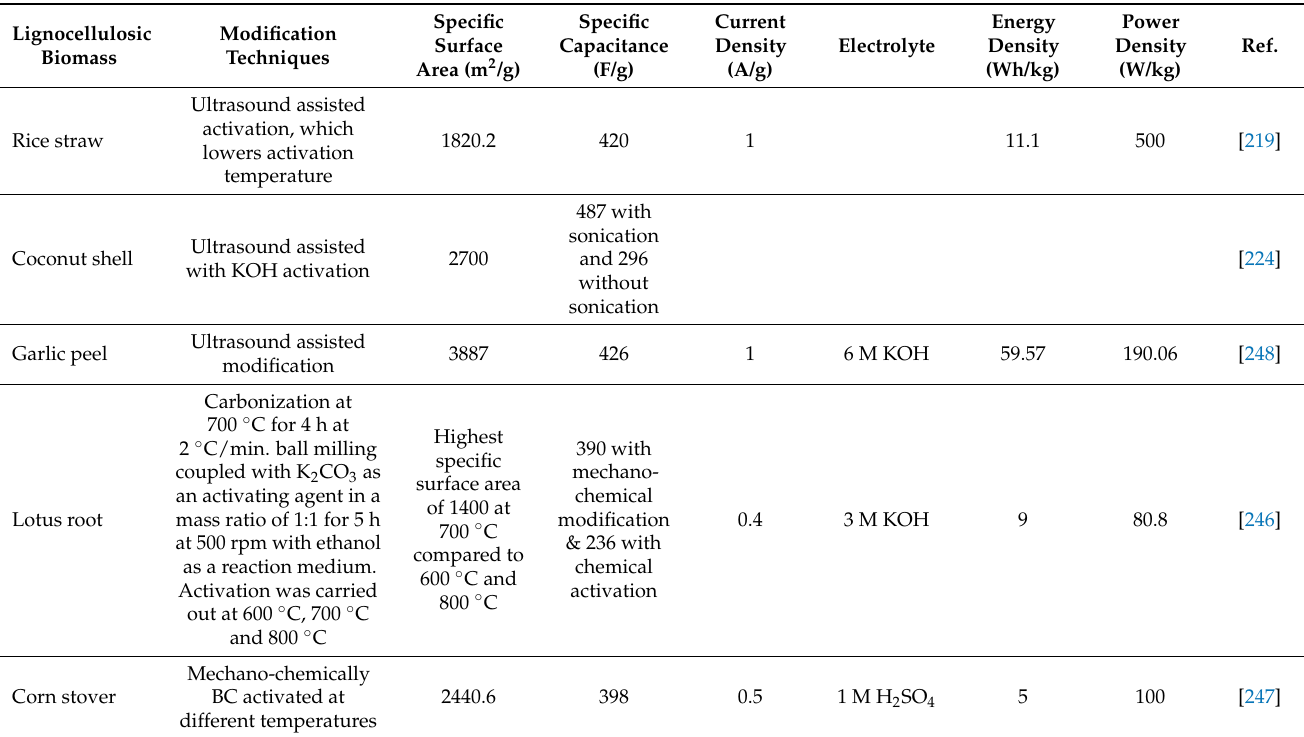
Table 5. Sonochemically and mechanochemically modified BC-based materials used for making electrode materials for supercapacitor